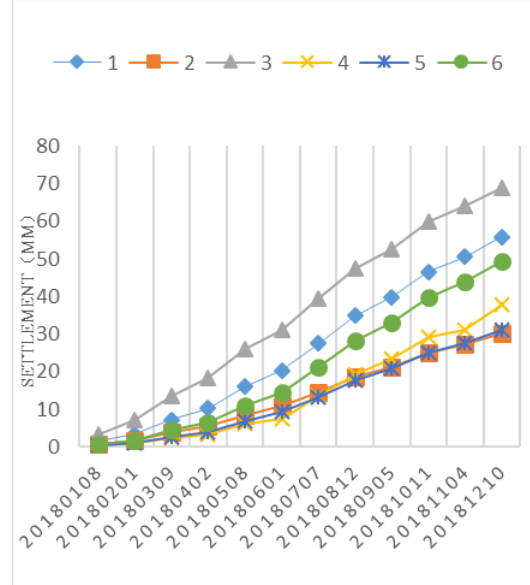
Figure 5. Deformation time series of the ground